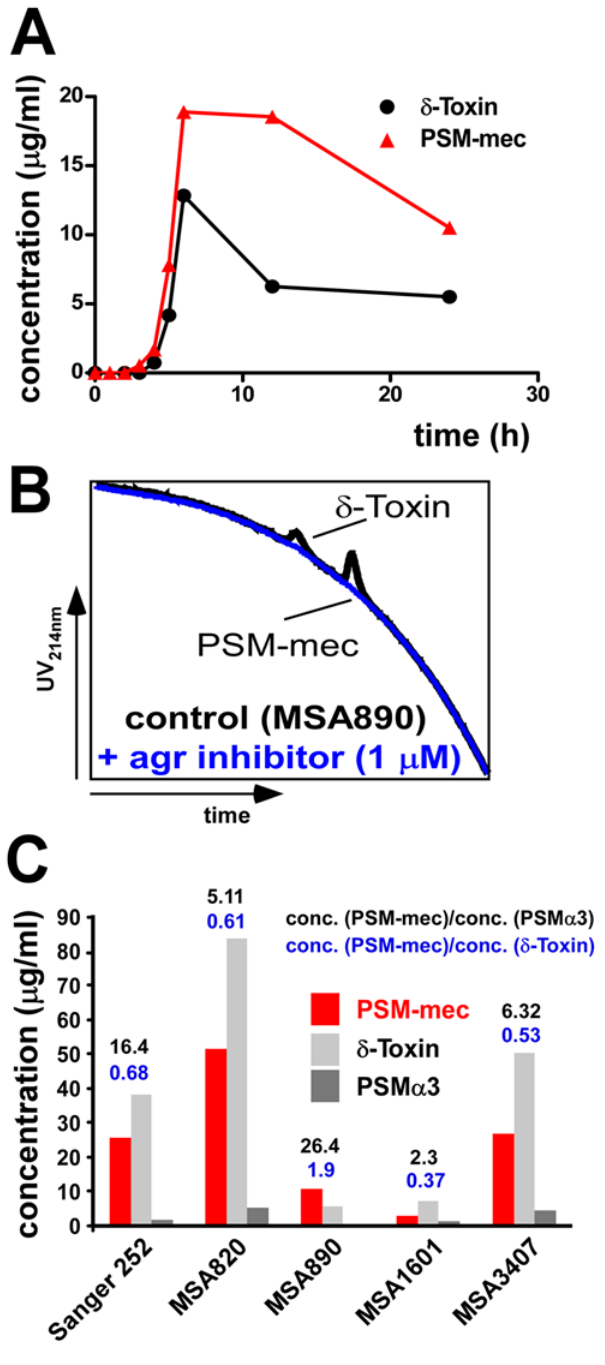
Figure 5. Characteristics of PSM-mec production and regula- tion in S. aureus . (A) Production of d -toxin and PSM-mec during growth in shaken culture. (B) PSM production in strain S. aureus MSA890 with and without addition of agr -inhibiting S. epidermidis autoinducing peptide [30,52]. With addition of inhibitor, no PSMs were detectable. (C) Production of selected PSMs at 8 h of growth in the PSM-mec producing S. aureus Sanger 252 and other MRSA strains [22].